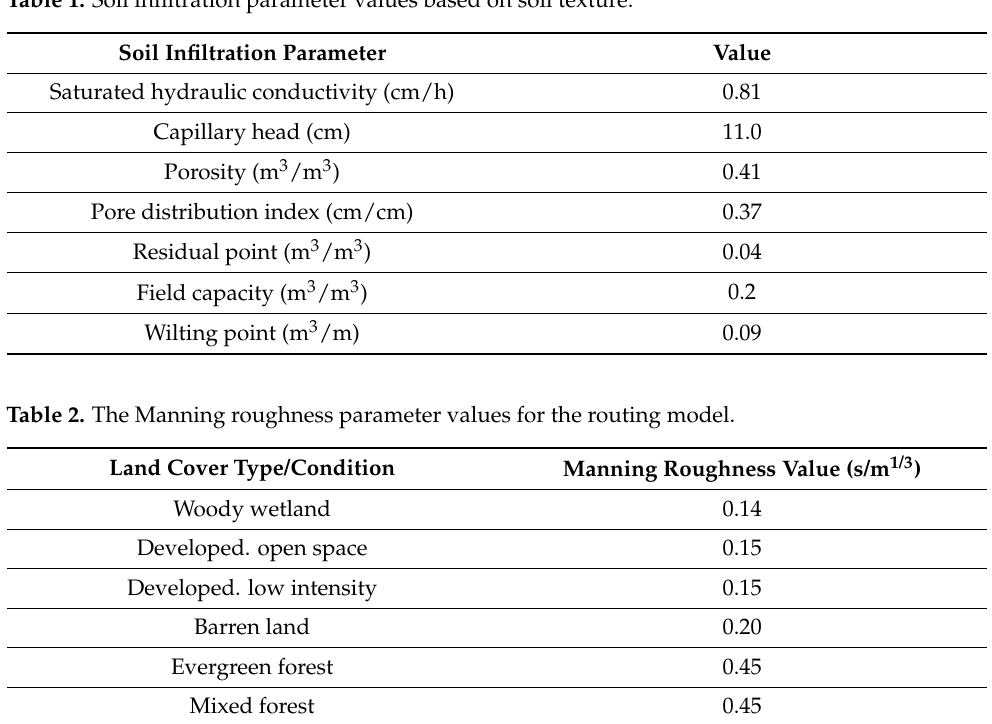
Table 1. Soil infiltration parameter values based on soil texture.